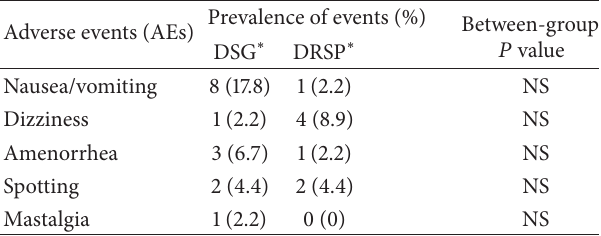
Table 6: The comparison of the prevalence of adverse effects (episodes per 100 samples) between both groups.